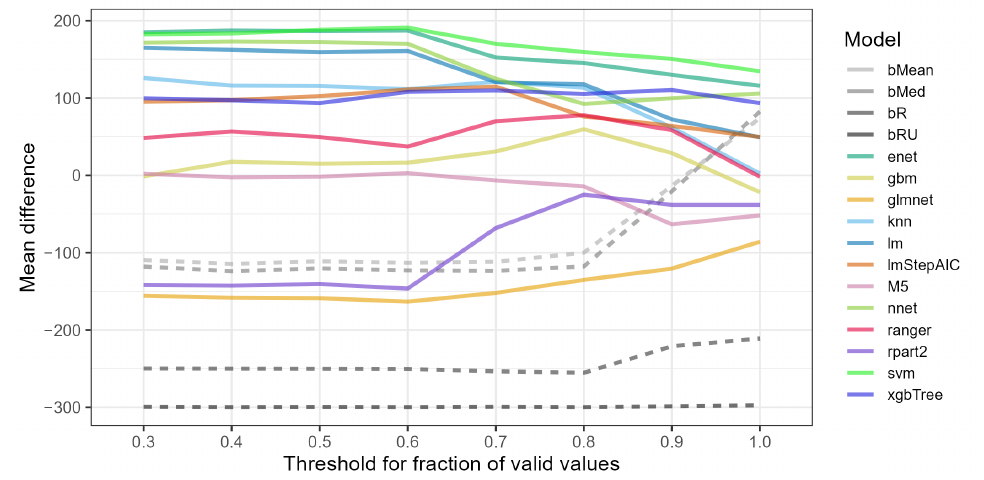
Figure 5. Mean difference of models for various thresholds for fractions of valid values. Each data point denotes a mean difference of a particular model for a given threshold for fractions of valid values across all investigated combinations of Data Quality Rating and UFP Rating in all